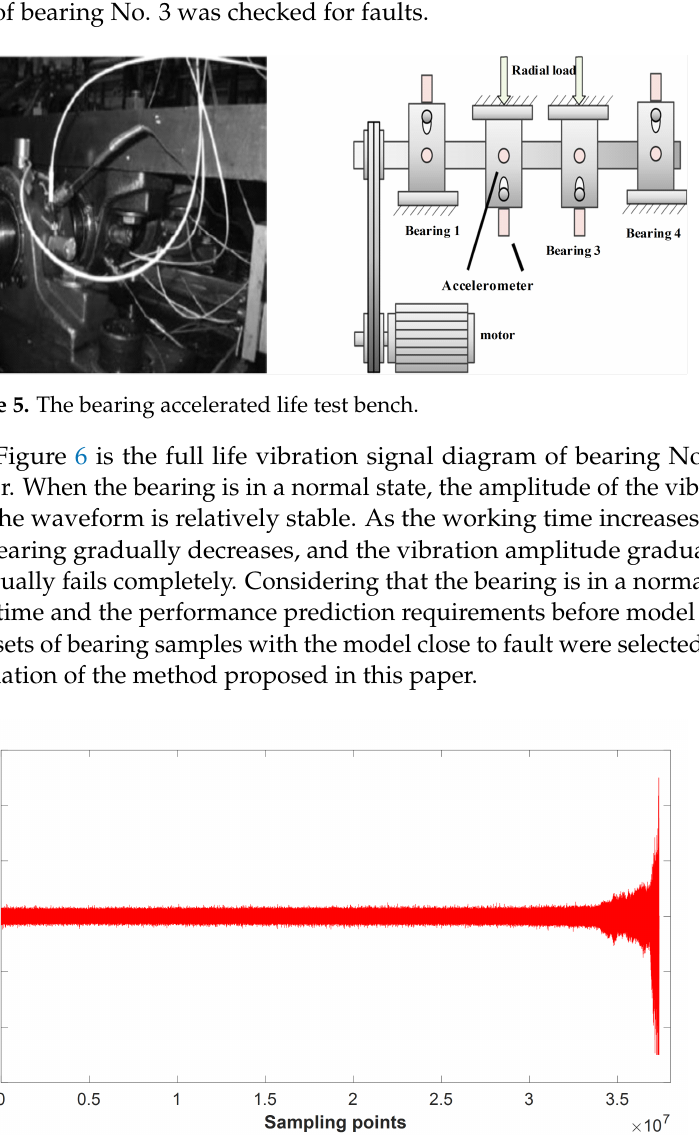
Figure 6. Variation in vibration signal over the full life of a rolling